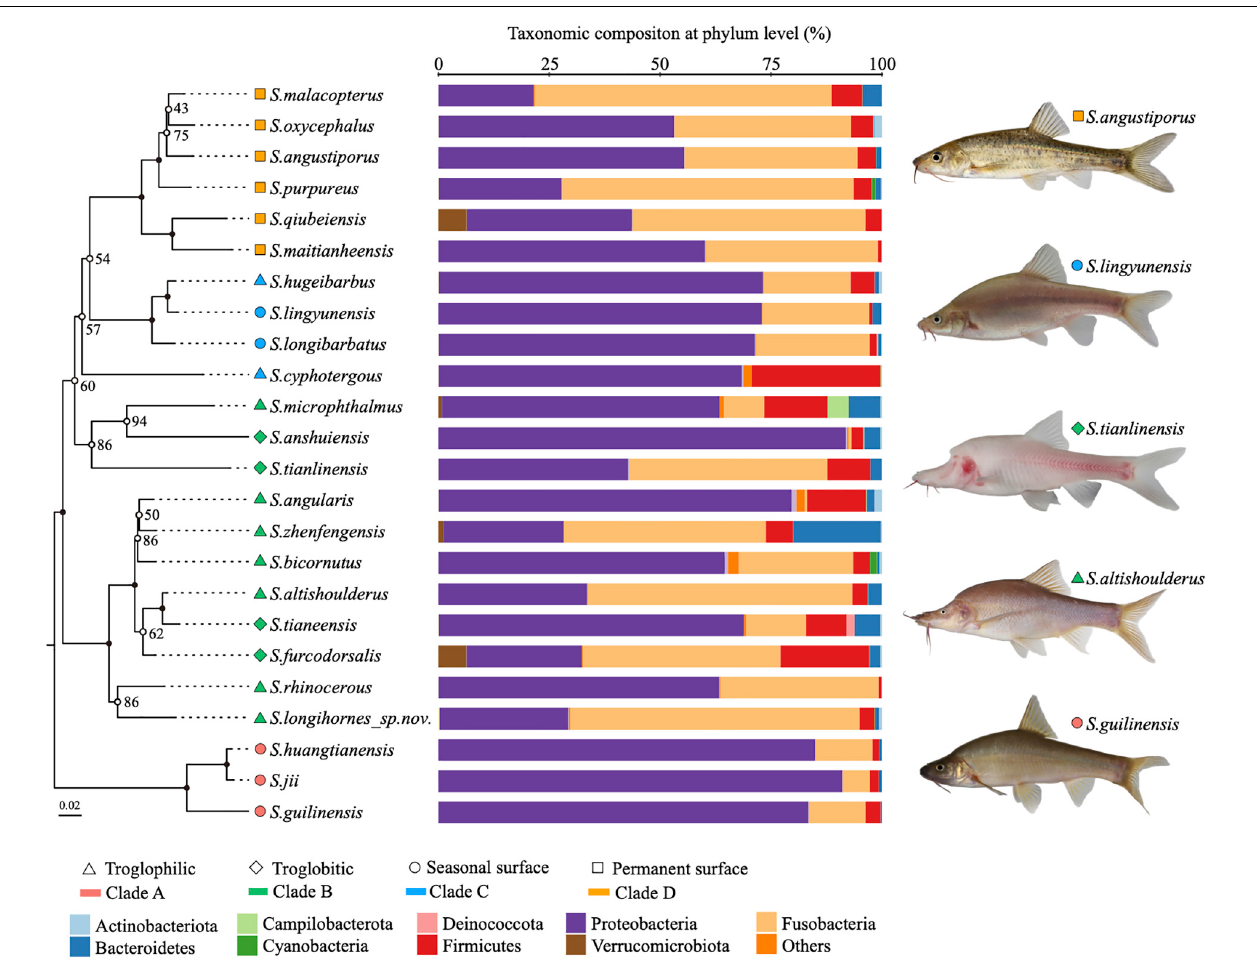
FIGURE 2 | Phylogenetic relationships and microbial affinities of Sinocyclocheilus species ( N = 24). (Left) The maximum likelihood phylogenetic tree based on concatenated cytb and ND4 gene fragments of 24 Sinocyclocheilus species, with 1,000 bootstrap replicates. Filled circles on the node represents bootstrap support is 100; (Middle) phylum level composition of the gut microbiome. The microbial community for each species is displayed as the sum of all individuals within a given species; (Right) images of representative species from the four main phylogenetic